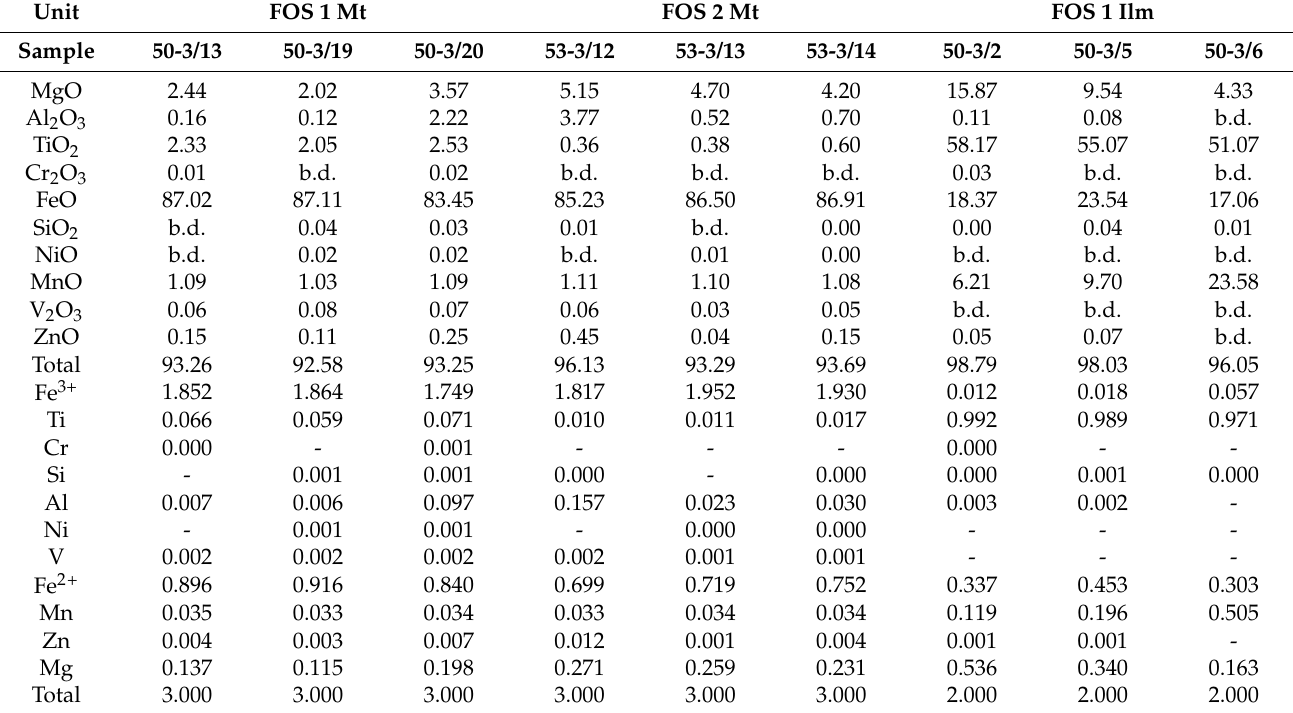
Table 1. Representative compositions of magnetite and ilmenite from the phoscorites of the Arbarastakh massif. b.d. = below the detection limit. The structural formulae of magnetite are calculated to three cations.